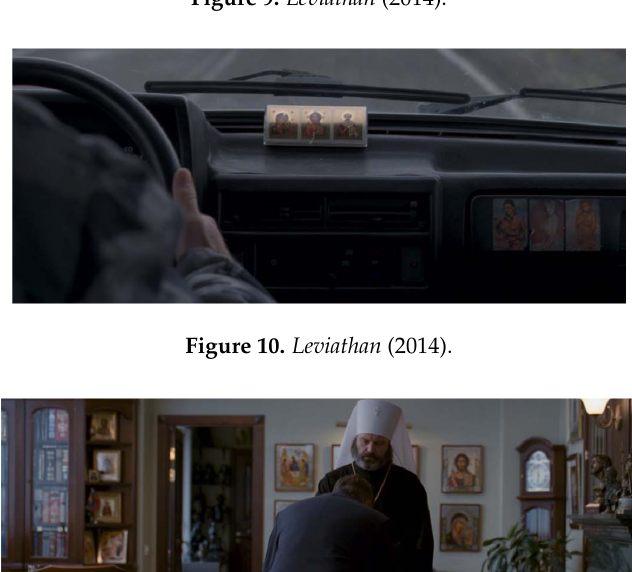
Figure 9. Leviathan (2014).